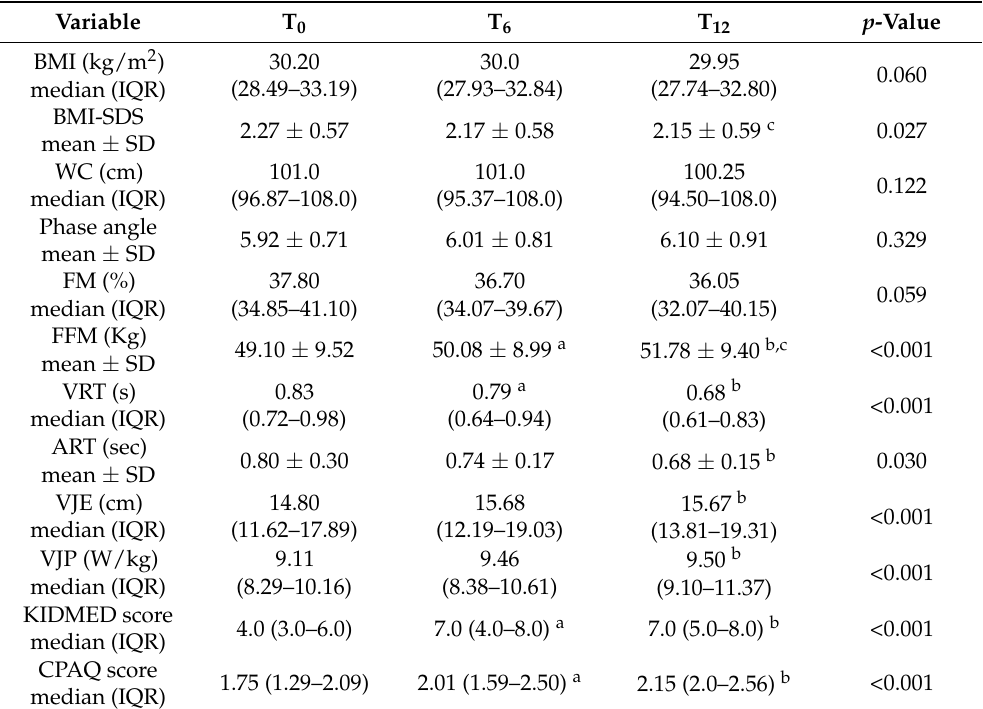
Table 2. Changes in adolescents’ (n = 42) anthropometric, motor and behavioral variables across the three times of